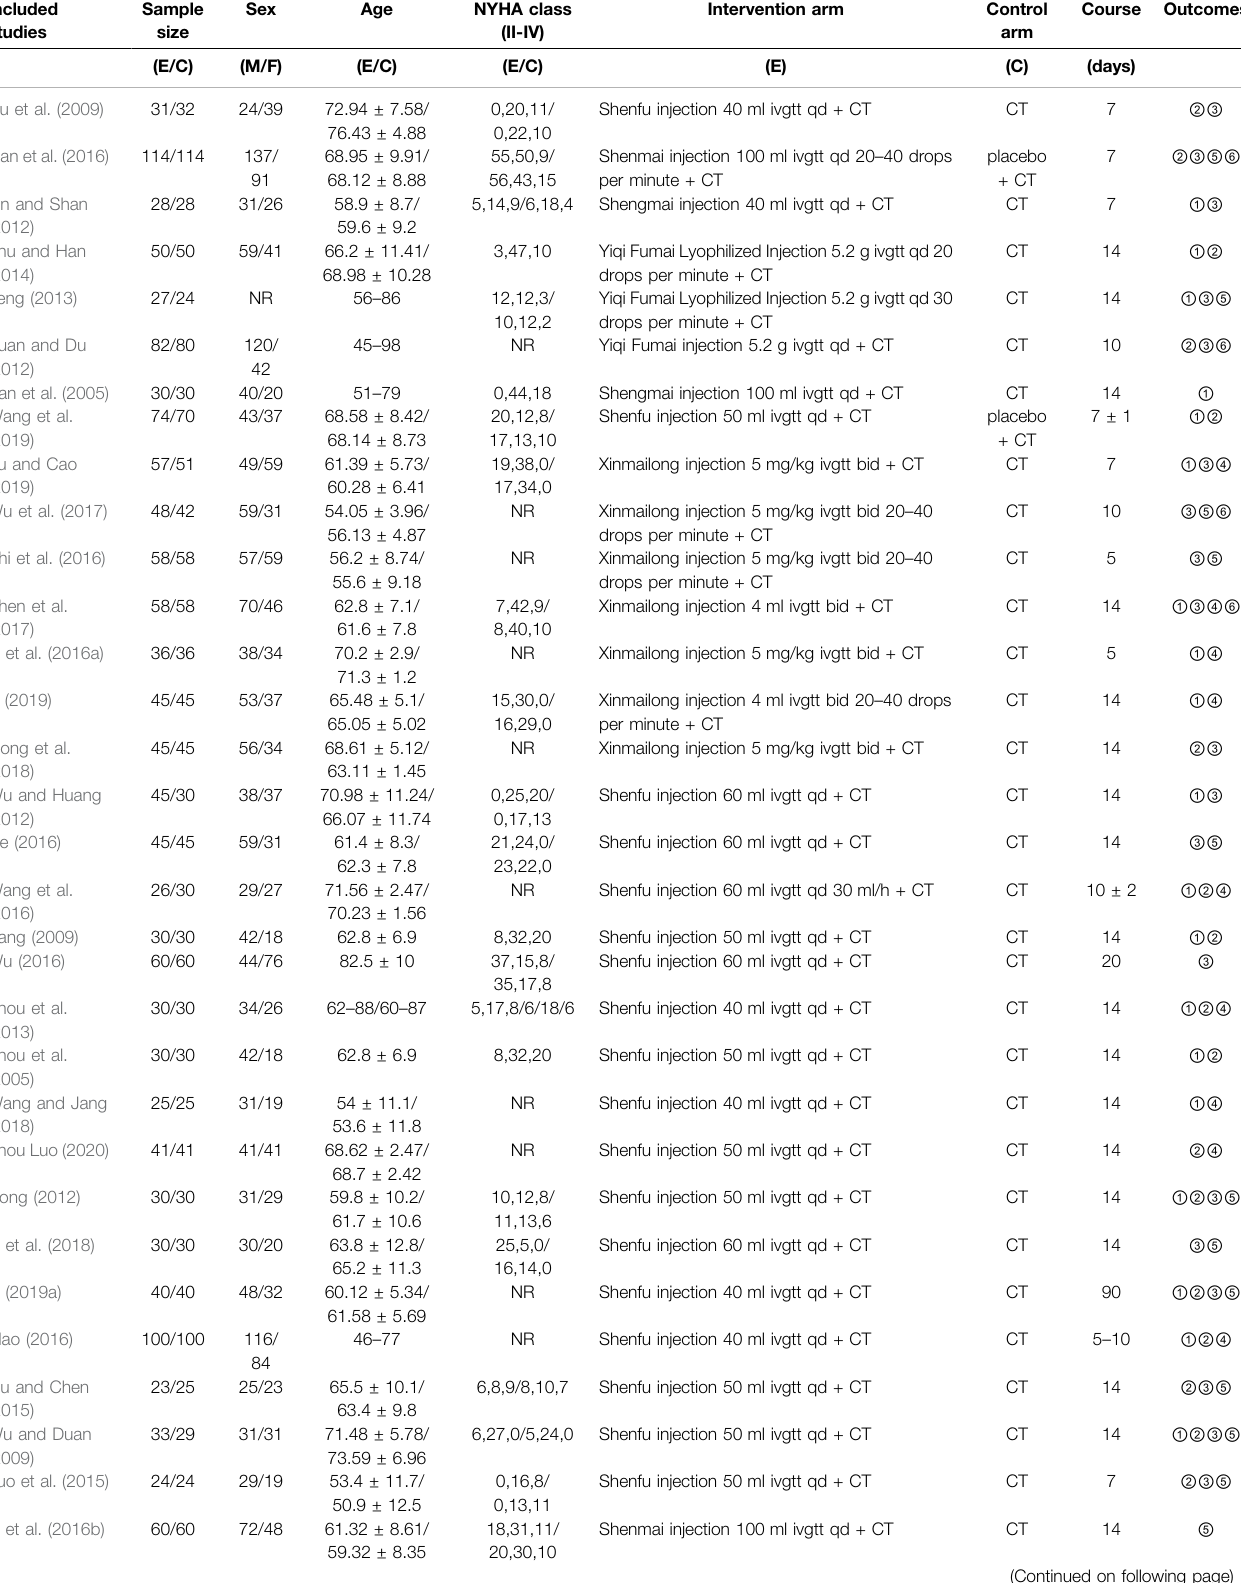
TABLE 1 | Baseline characteristics of studies included in the network meta-analysis. Included